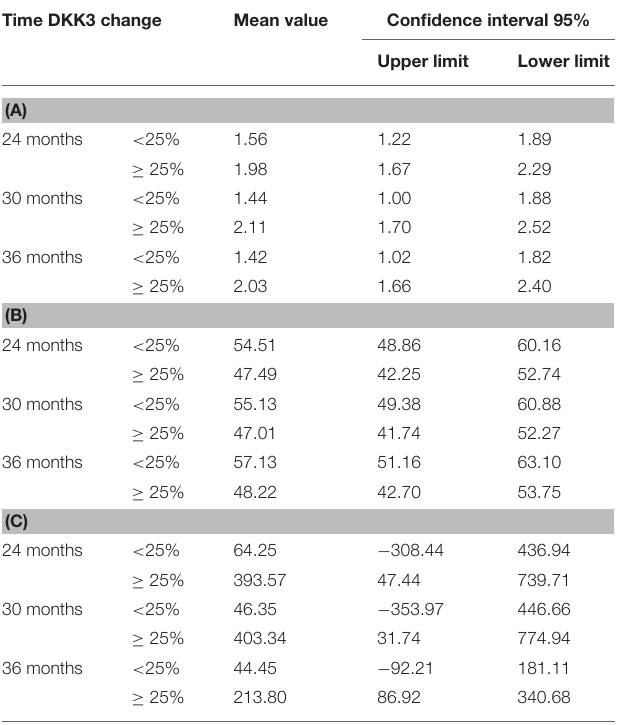
TABLE 2 | (A) Medium creatinine values depending on the DKK3 change of month 3–12 ( ≥ 25 vs. < 25%). Time DKK3